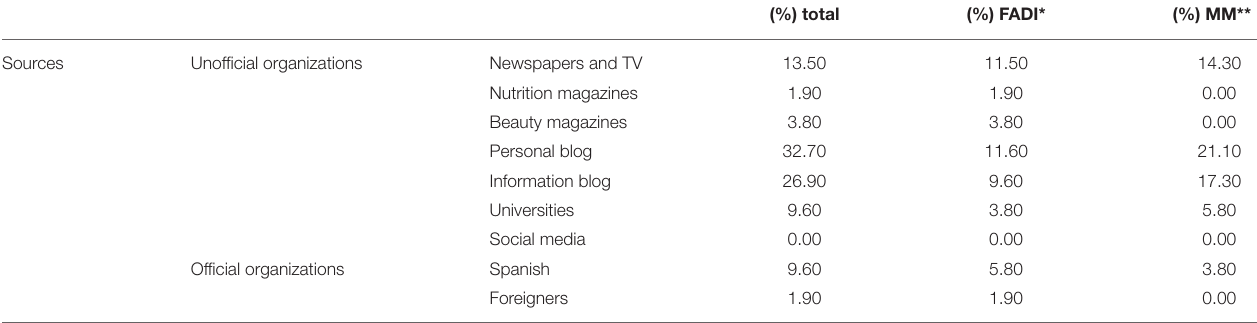
TABLE 1 | Type of information published according to